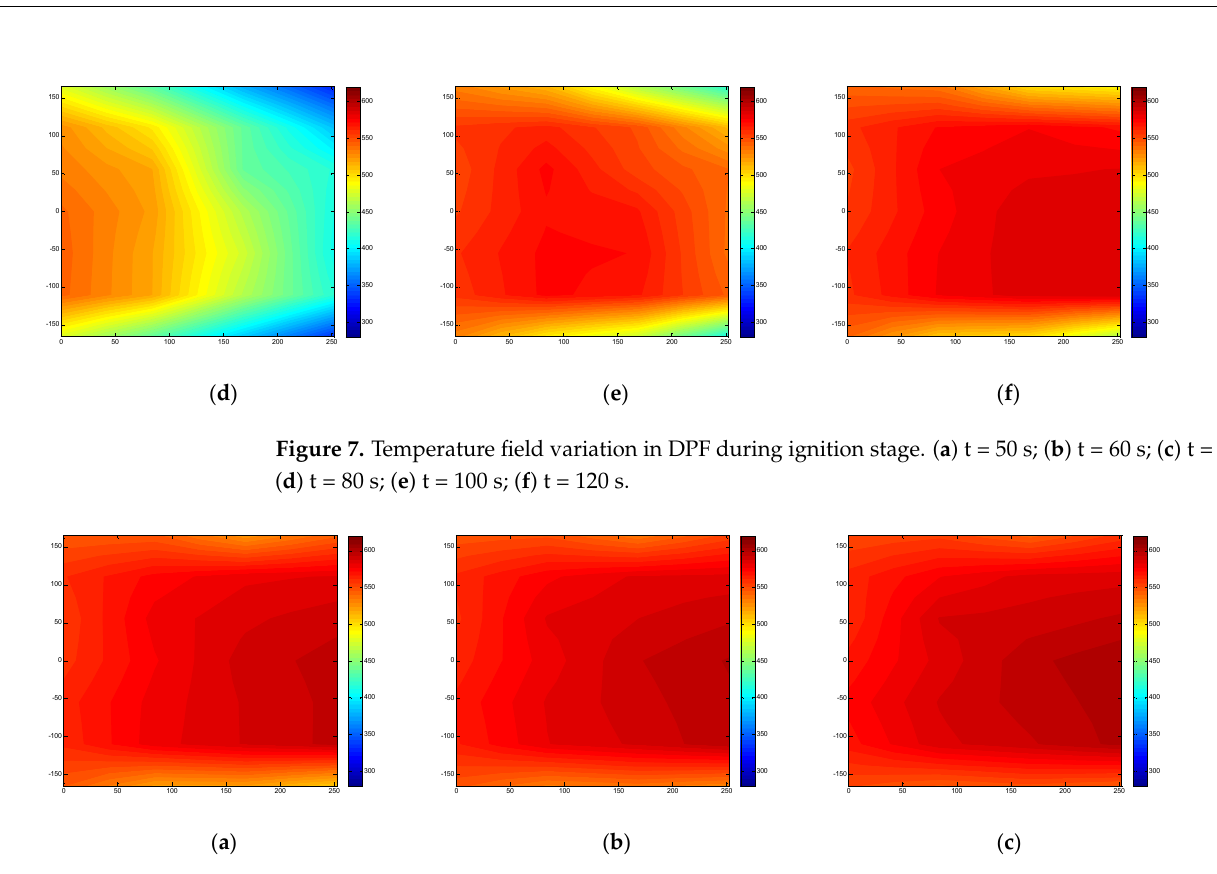
Figure 8. Temperature field variation in DPF during the regeneration stage. ( a ) t = 200 s; ( b ) t = 500 s; ( c ) t = 1000 s. The temperature change inside the DPF at the end of the regeneration stage is shown in Figure 9. At this stage, the active regeneration system stops injecting diesel fuel, the engine exhaust flow rapidly removes the heat inside the DPF, and the internal